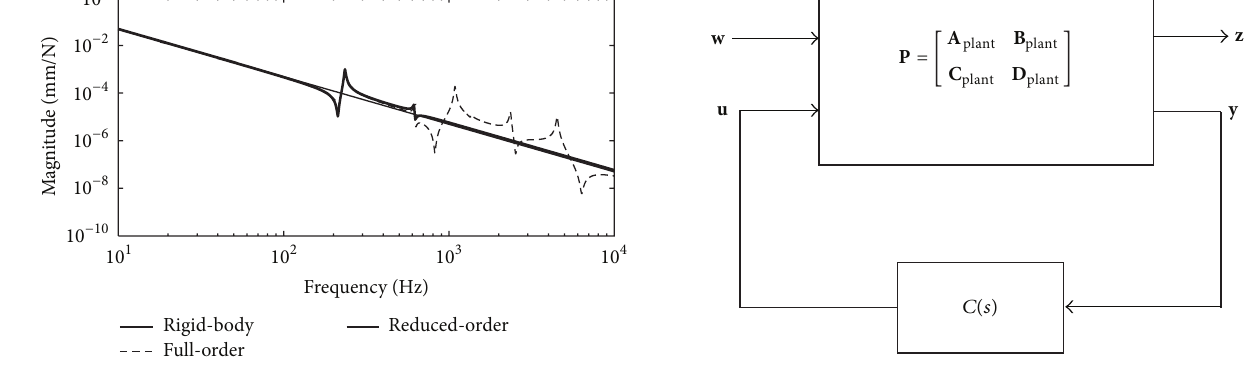
Figure 3: Reduced-order rotor model in frequency domain. Rigid- body model and full FE model are given for comparison.